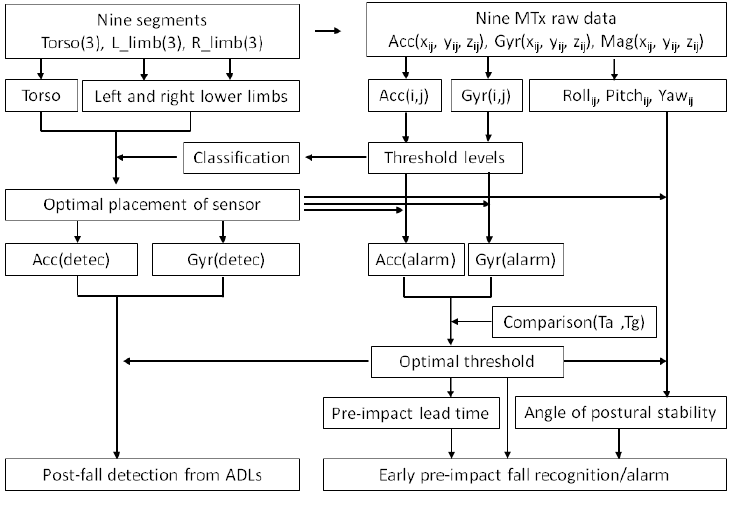
Figure 2. Flow diagram of our method for pre-impact fall recognition/alarm and post-fall